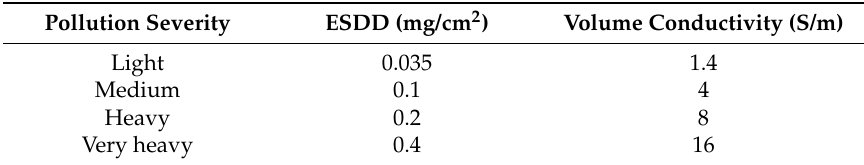
Table 1. Equivalent salt deposit density (ESDD) and volume conductivity at different pollution severity levels.